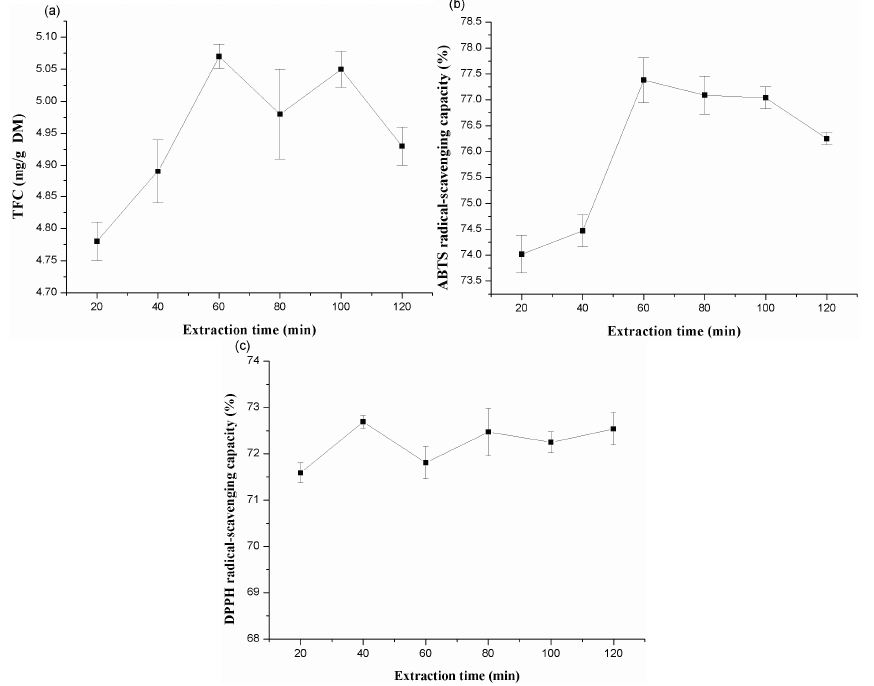
Figure 3. Effects of extraction time on the extraction yield of total flavonoids ( a ); ABTS ( b ) and DPPH ( c ) radical-scavenging capacities of extracts from